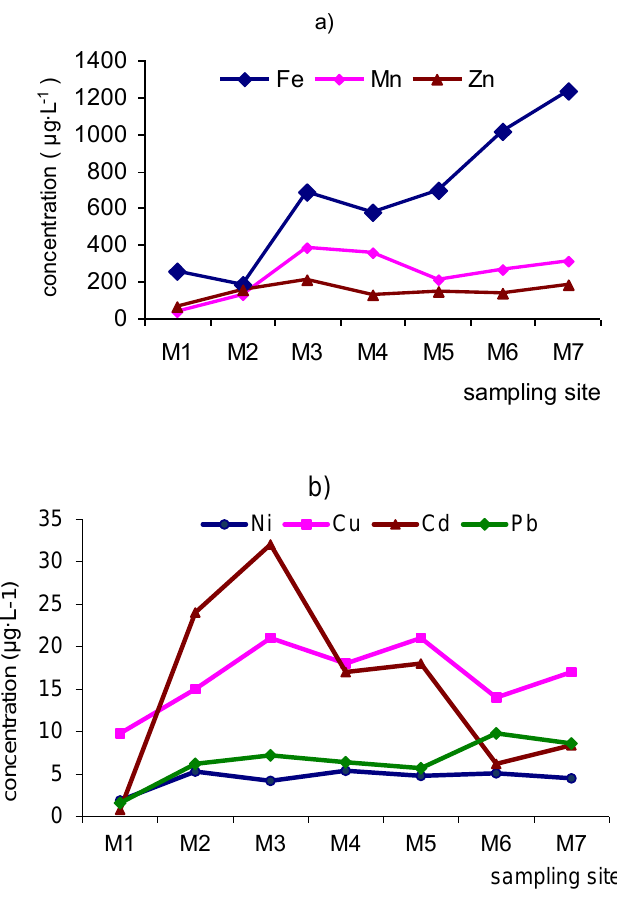
Figure 7. Variation of suspended phase Fe, Mn, Zn ( a ), Ni, Cu, Cd, Pb ( b ).